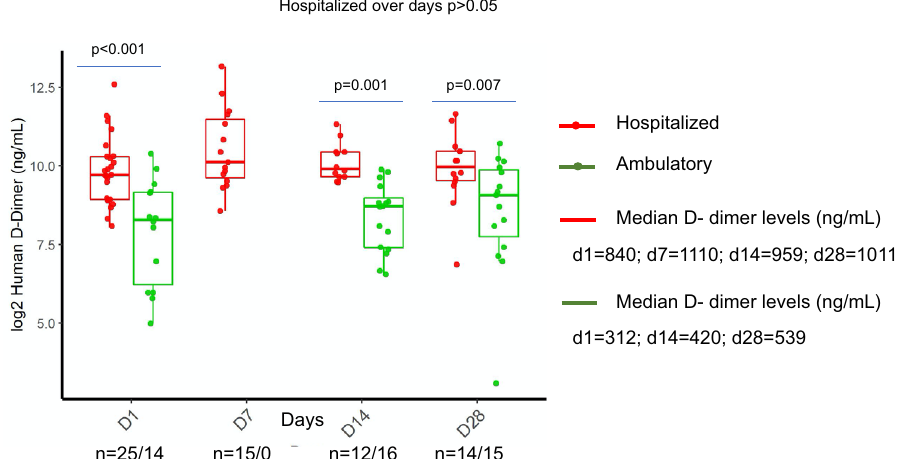
Figure 1. Longitudinal monitoring of D-dimers in hospitalized and ambulatory COVID-19 patients. Figure was created using ggplot2 package version 3.3.0. supported on R program software 38 .